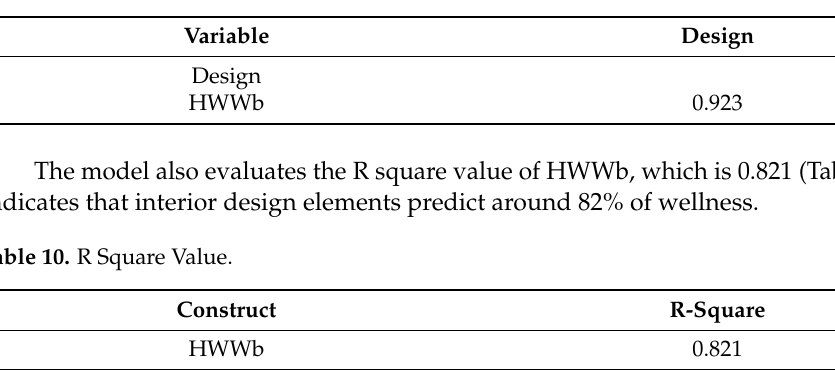
Table 9. Heterotrait-Monotrait Ratio.